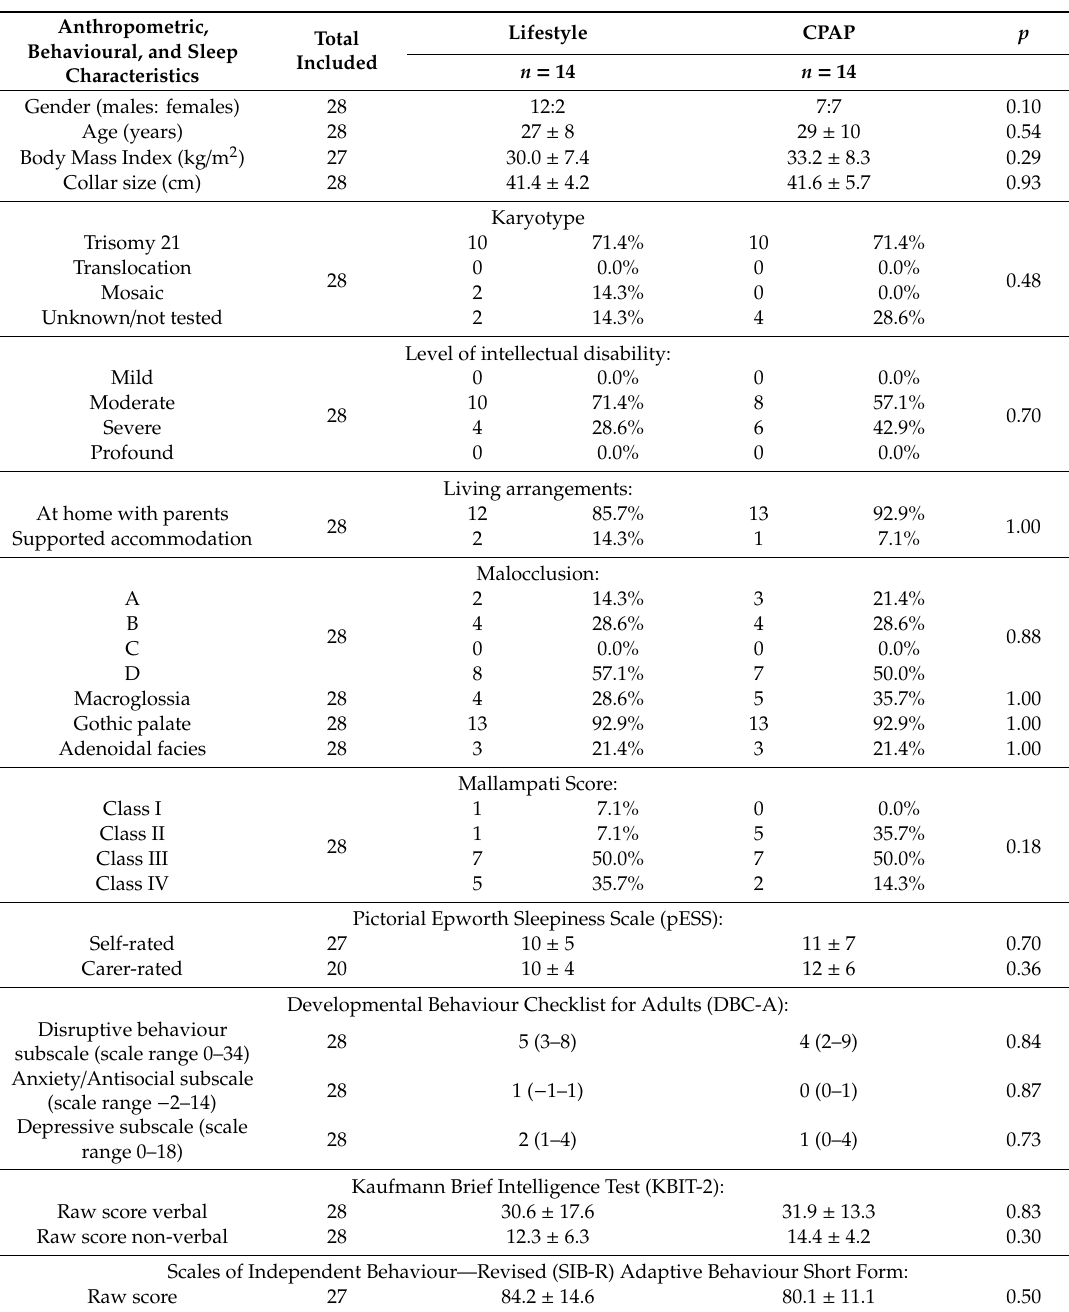
Table 1. Characteristics of randomisation groups at baseline—pre-CPAP (mean ± SD or median (IQR) as appropriate). CPAP: continuous positive airway